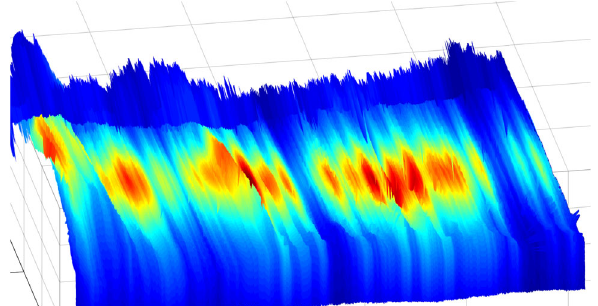
Fig. 19 3D roof surface with overlaid radar amplitude